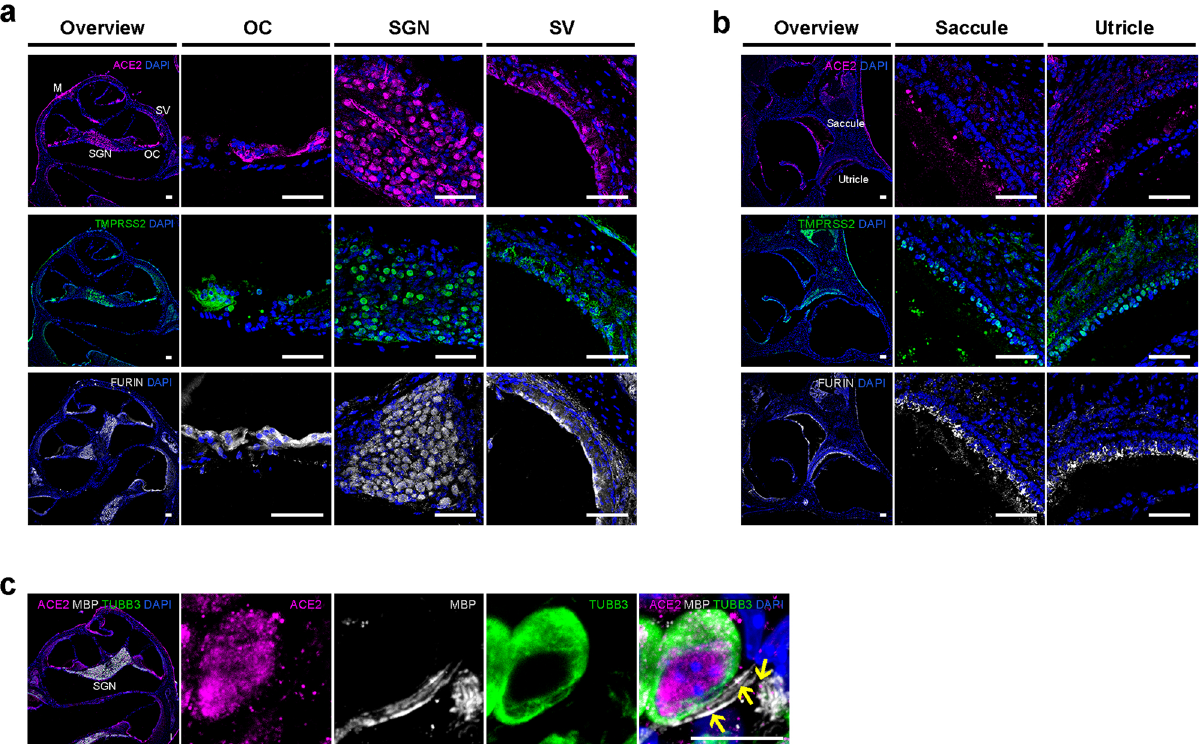
Fig. 6 Expression of SARS-CoV-2 cell entry-related receptor and entry-associated proteases in different cell types of the mouse inner ear. a , b The presence of ACE2, TMPRSS2, and FURIN in the mouse cochlea ( a ) and vestibule ( b ). In the cochlea, all 3 protein-positive cells are located in the OC, which contains sensory hair cells and supporting cells, the SGNs, which innervate hair cells, and the SV, which contains numerous blood vessels. In the vestibule, the cells co-expressing all 3 proteins are located in the saccule and utricle. Data are representative images from at least 3 independent experiments. Scale bars = 50 μ m. c Small expression of ACE2 (indicated by yellow arrows) in MBP-expressing Schwann cells. Data are representative images from 3 independent experiments. Scale bars = 10 μ